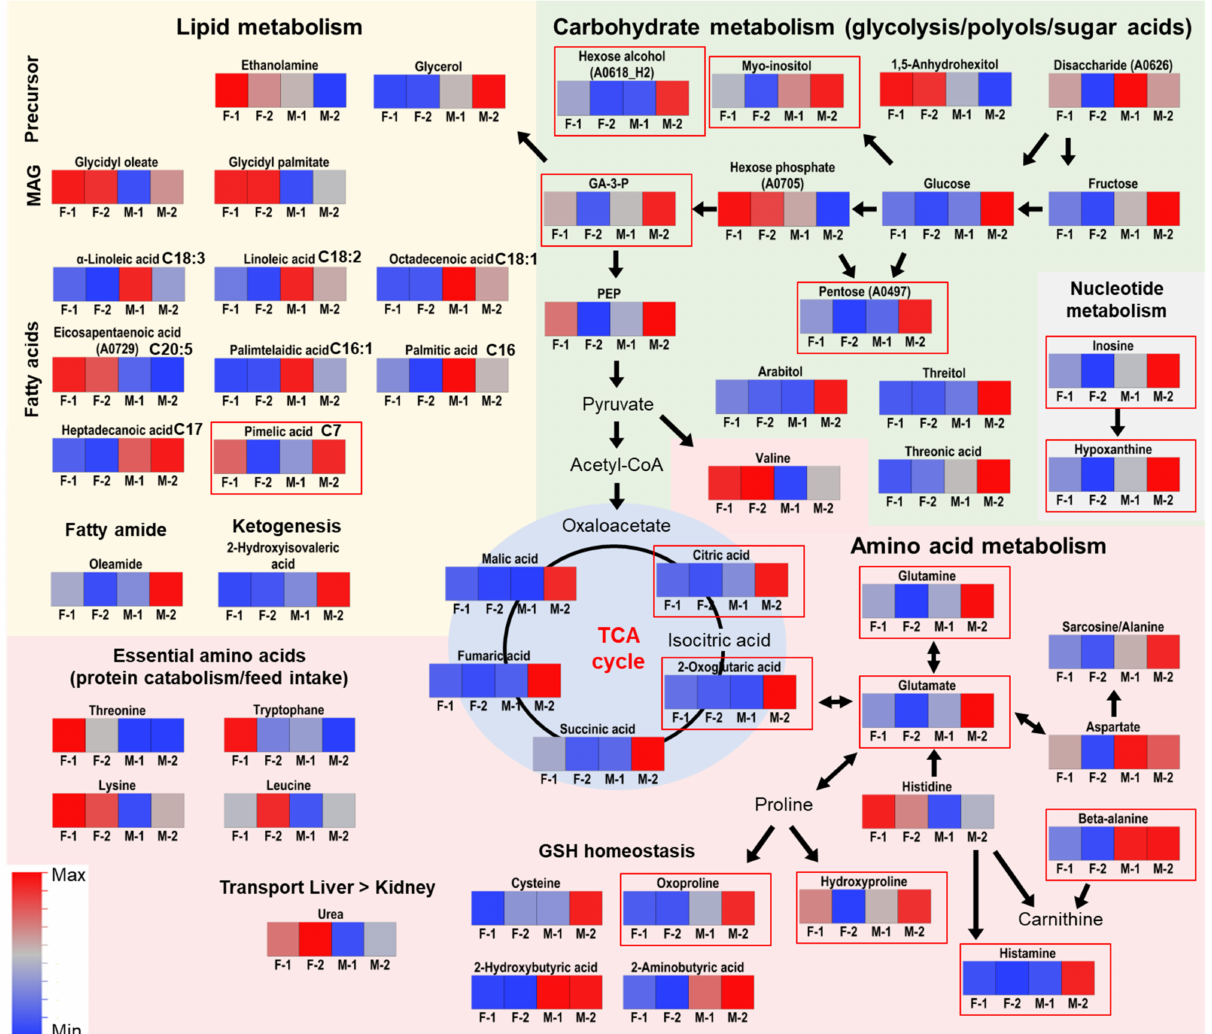
Figure 3. Pathway integration of varying metabolites in blood. Relevance of metabolites was determined by univariate statistical testing and OPLS-DA. Metabolites illustrated in red frames were found to be significantly different between boars and gilts (as observed by Tukey’s HSD Test or Steel-Dwass Test). Visualized are the unit variance scaled means of the respective signal intensities displayed as color coded